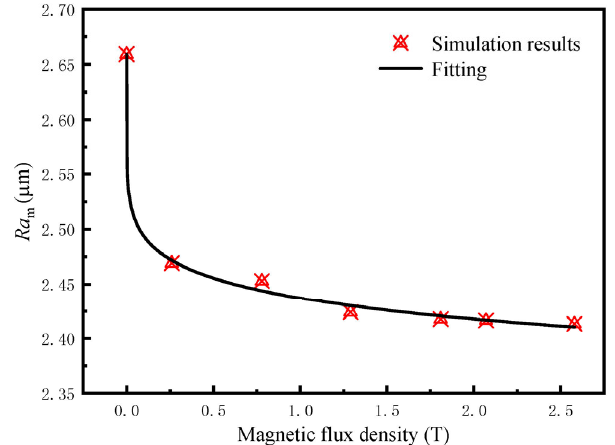
Fig. 7 Surface roughness of MREs change with magnetic field